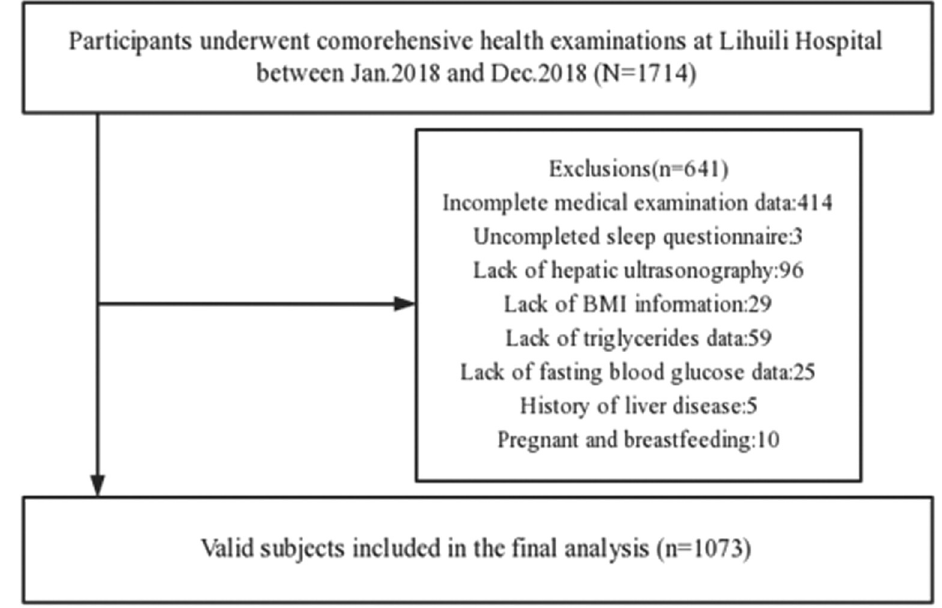
Figure 1: Flowchart of the included